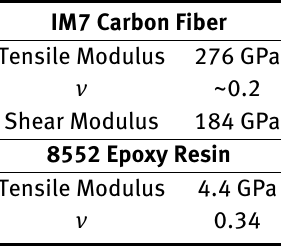
Table 2: Mechanical Properties Fiber and